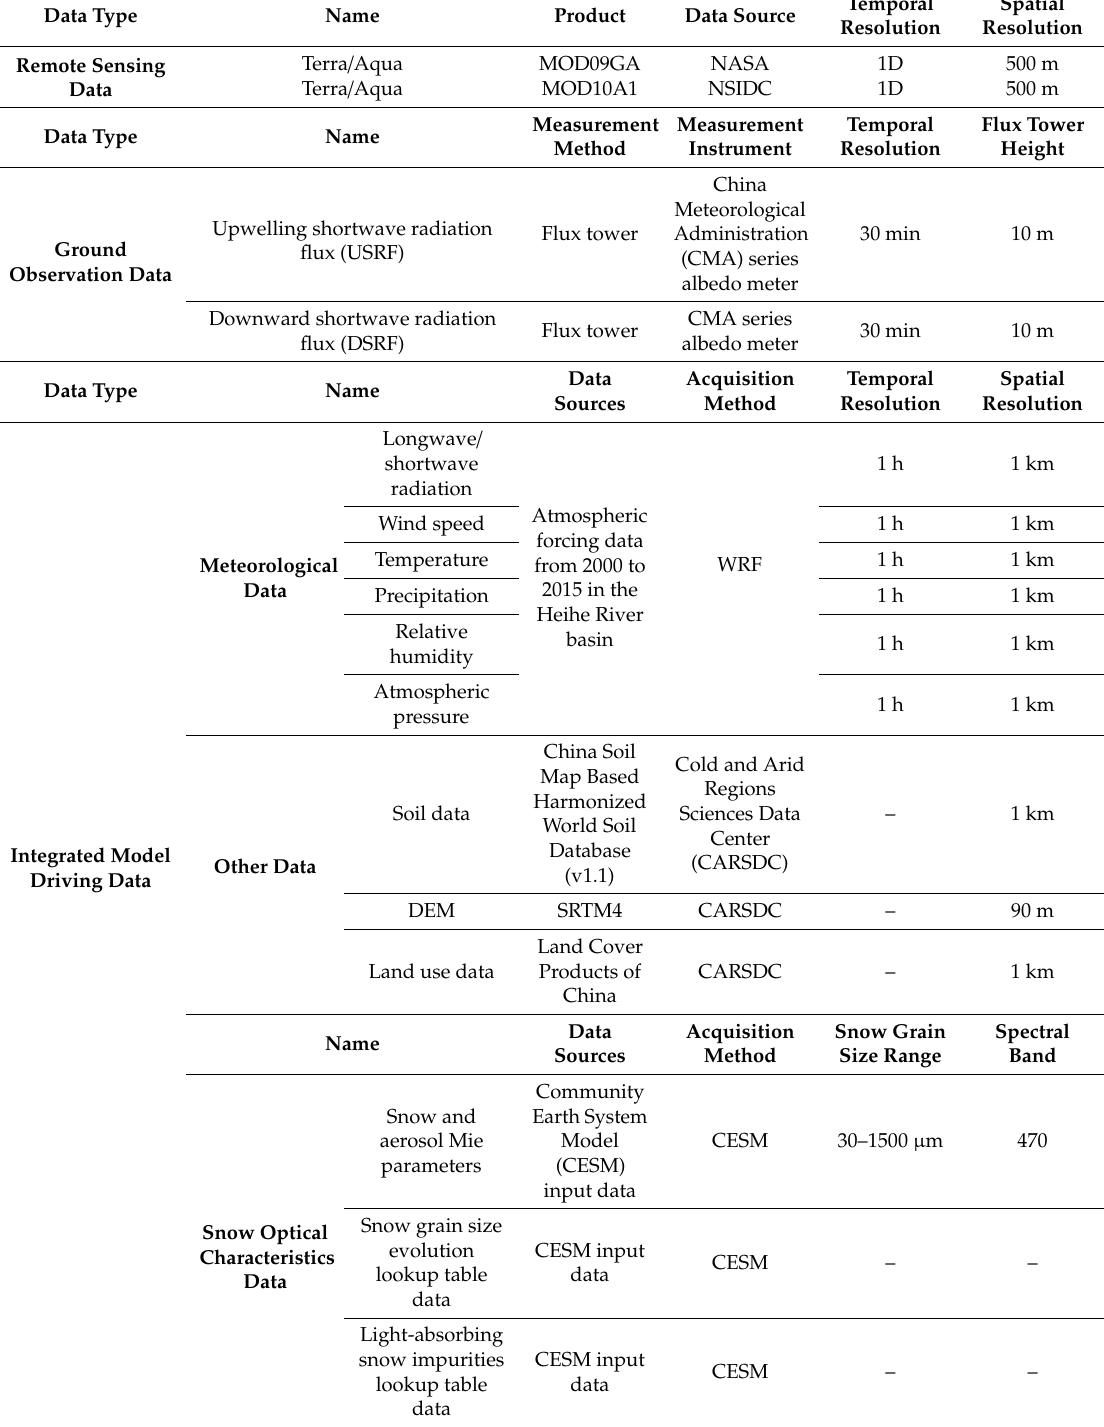
Table 1. Driving data and validation data required for the integrated